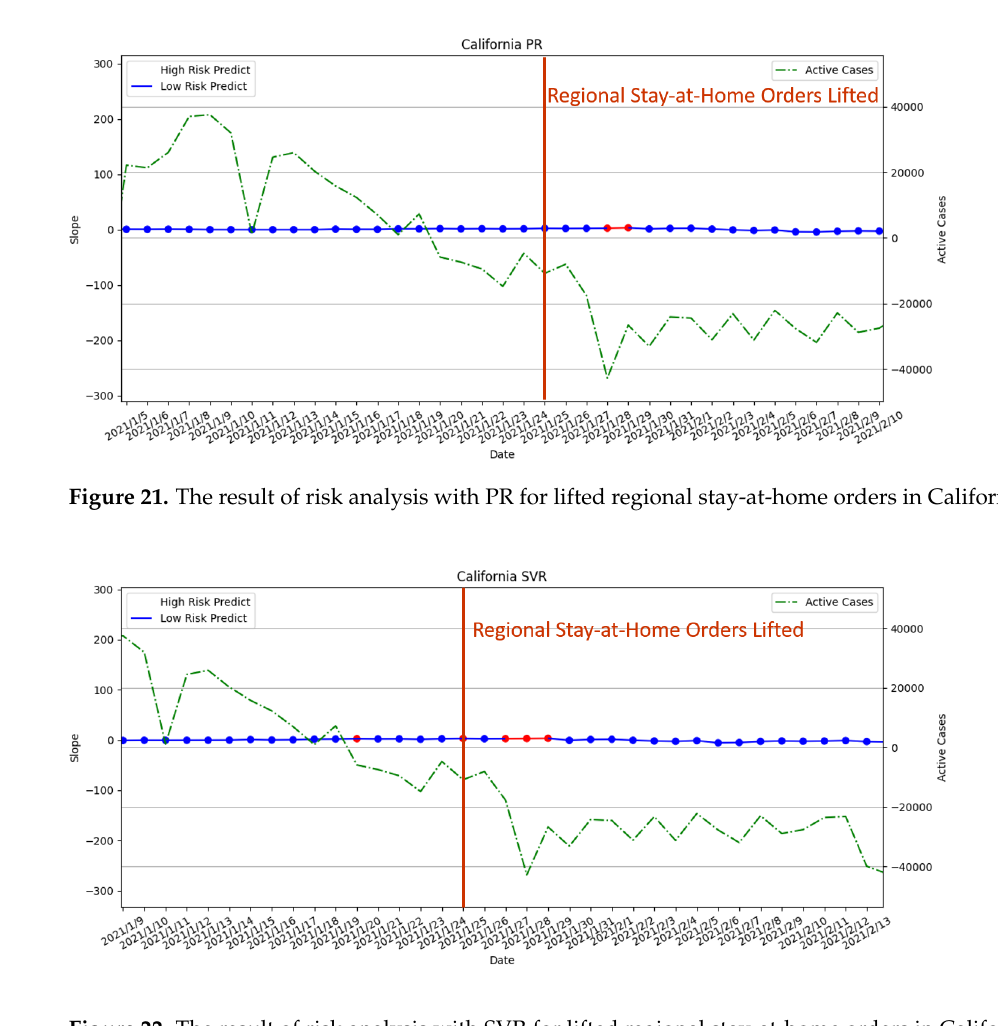
Figure 22. The result of risk analysis with SVR for lifted regional stay-at-home orders in